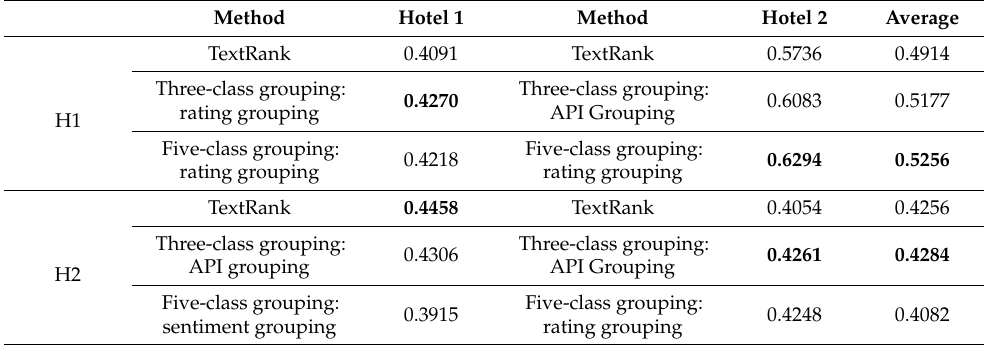
Table 11. Summary of the best ROUG-1 F scores achieved for both